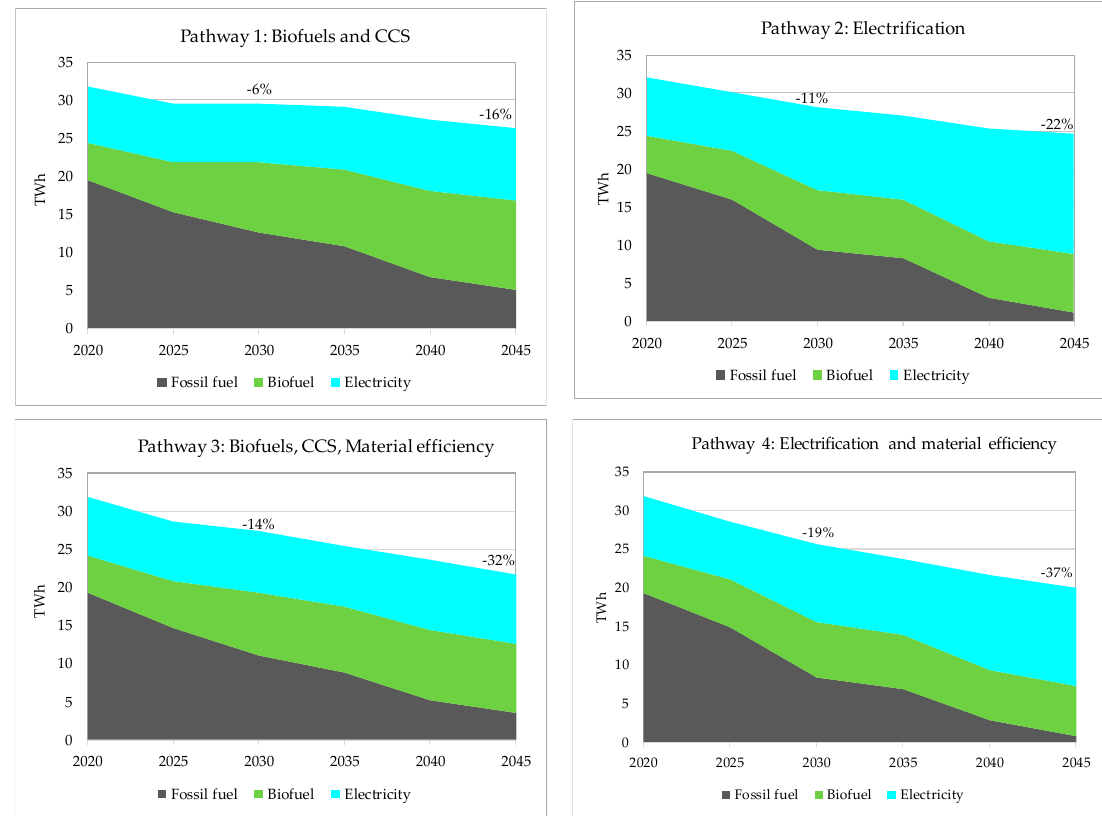
Figure 7. Energy use for each energy carrier over time for the buildings and transport infrastructure pathways.